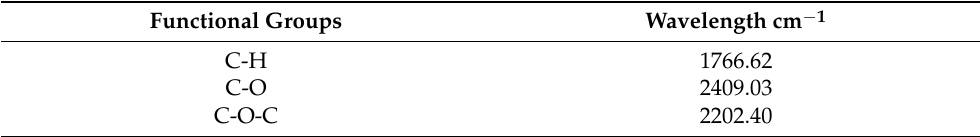
Table 7. Wave number for each functional group of